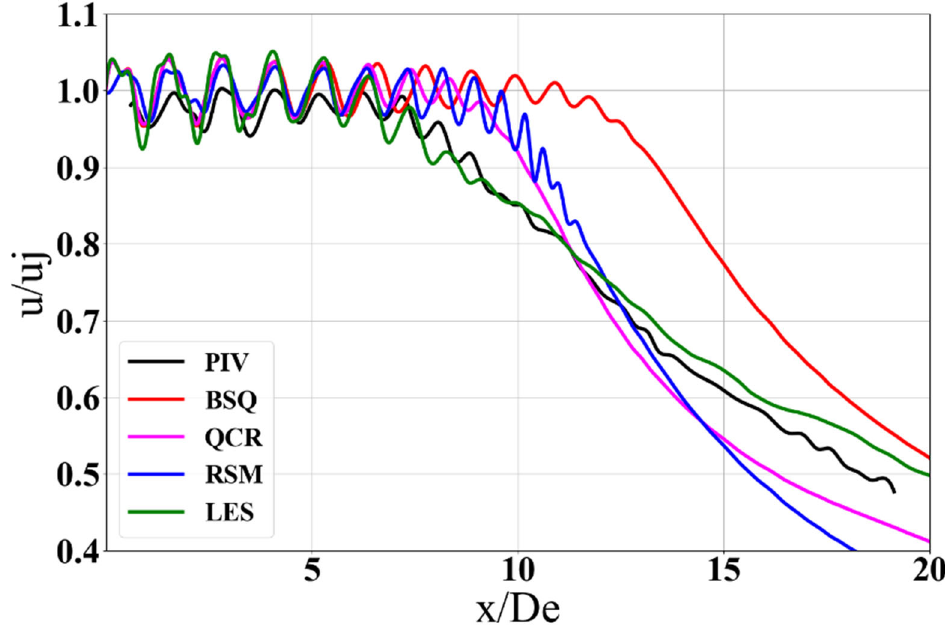
Figure 17. Jet centerline velocity comparison with PIV data from [60]—Boussinesq SST RANS, QCR, RSM and LES.